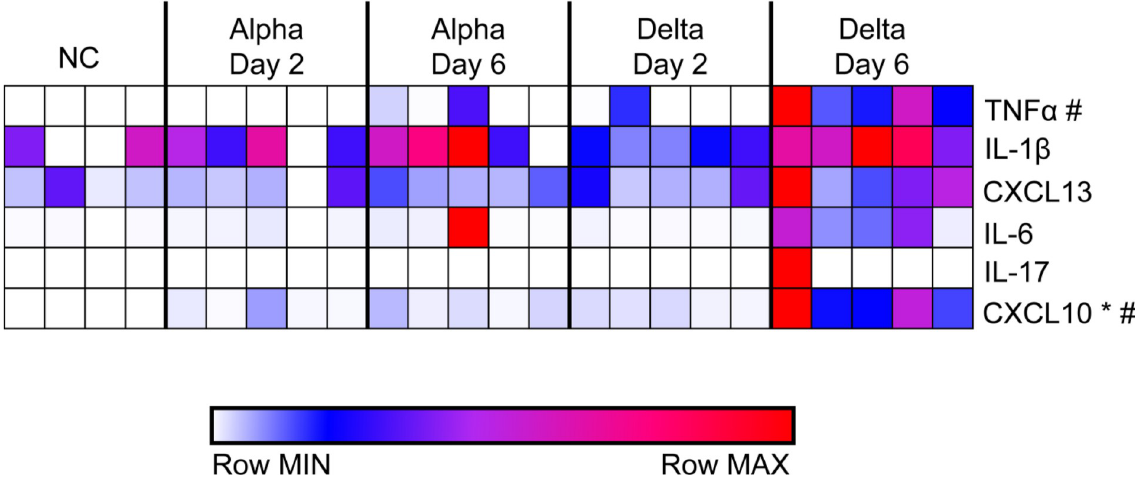
Fig 4. Analysis of cytokines production in lung supernatants from Alpha or Delta challenged K18-hACE2 transgenic mice at 2- or 6-days post-challenge. Non-challenged, Alpha- or Delta-challenged lung supernatants were used to determine local cytokine production in response to challenge. Concentrations (pg/mL) were graphed using Morpheus to reveal relative levels of cytokines compared to non-challenged lungs. � = statistical significance between Alpha day 6 and Delta day 6 (One-Way ANOVA P = 0.0105). # = statistical significance between no challenge and Delta Day 6 (One-Way ANOVA P = 0.0225 TNF α ; P = 0.0058 CXCL10). (n = 5 except in NC where n = 4).